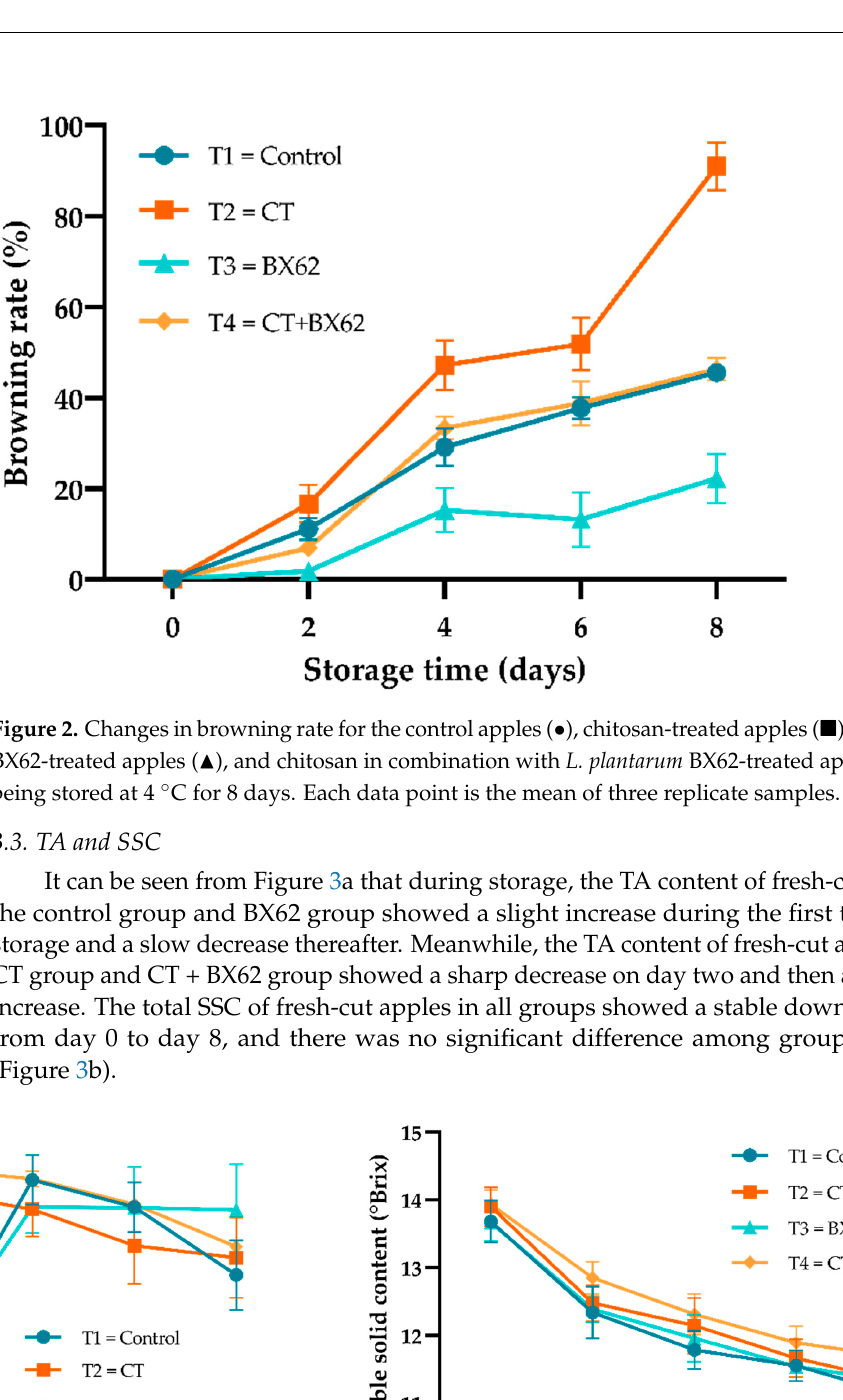
Figure 3. Changes in TA ( a ) and SSC ( b ) for the control apples ( ● ), chitosan-treated apples ( ■ ), L. plantarum BX62-treated apples ( ▲ ), and chitosan in combination with L . plantarum BX62-treated apples ( ◆ ) after being stored at 4 °C for 8 days. Each data point is the mean of three replicate samples. 3.4. Total Phenolic Content The total phenolic content of fresh-cut apples in each group showed a tendency to increase at the early stage of storage and then decreased slowly at 2–8 days of storage (Figure 4). Notably, the TPC under the BX62 treatment was the highest among all treat- ments, while the CT treatment was the lowest ( p < 0.05). Over the entire storage period,